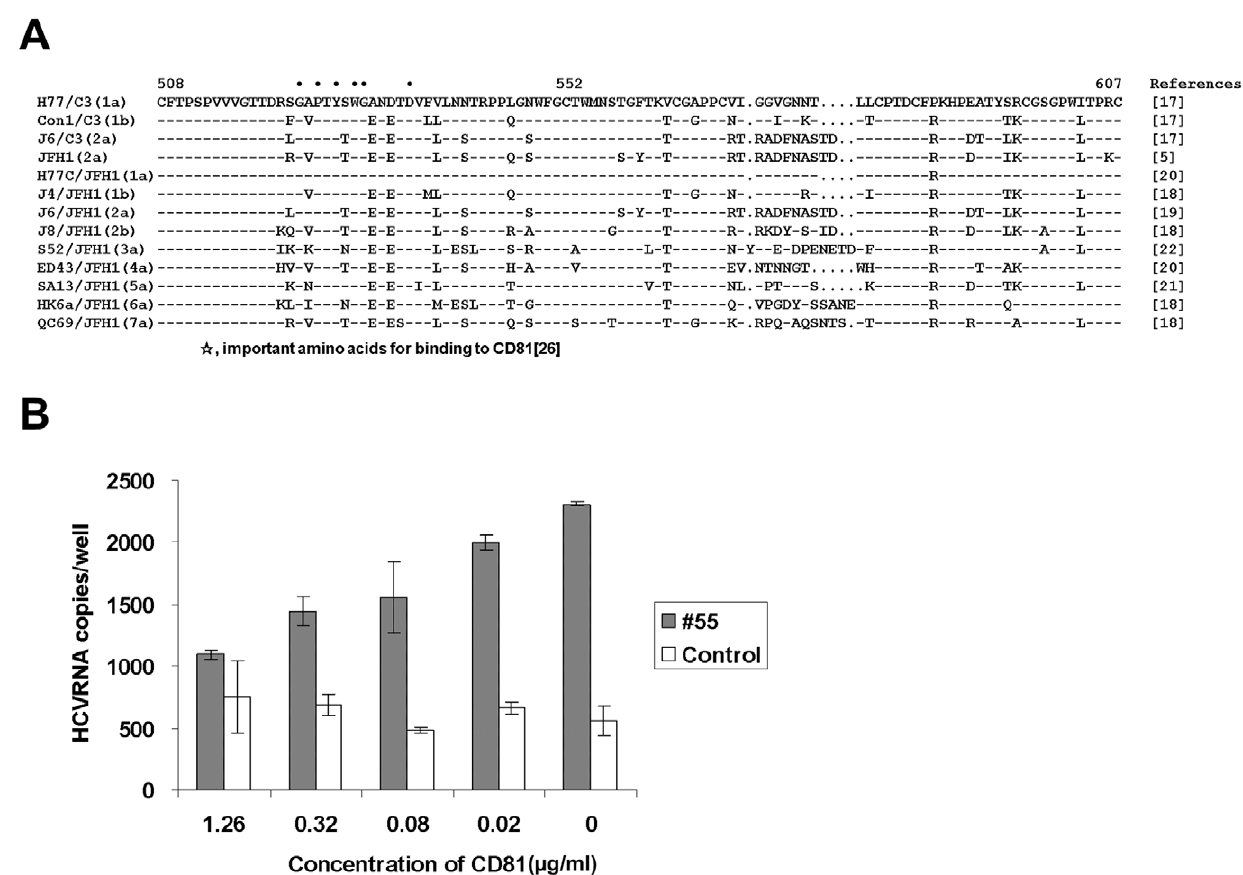
Figure 8. Binding of HCV to # 55 was inhibited by soluble recombinant CD81. ( A ). Sequence alignment of aa 508 to 607, the epitope of # 55, of various genotypes of HCV employed in the present study. Residues identical to the sequences of H77/C3 are indicated by a dash. Dots indicate gaps. ( B ). H77/C3 virus was treated with various dilutions of soluble CD81.The mixtures were inoculated into a 48-well plate that was pre- coated with # 55 or the control antibody. Amount of bound HCV RNA was measured by